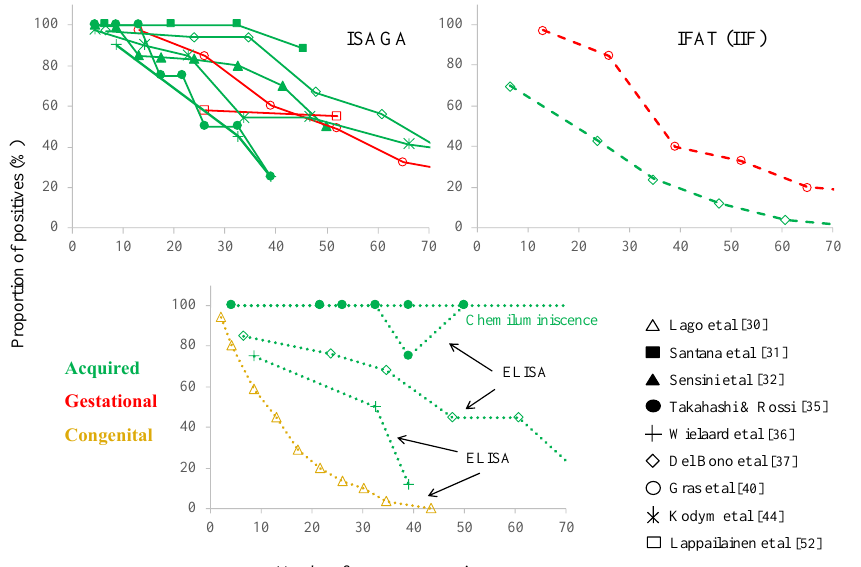
Figure 2. Proportion of cases positive for T. gondii reacting IgM antibodies over time in different groups after initial clinical or serological signs of infection [30 – 32,35 – 37,40,44,52]. Each graph corre- sponds to the test employed, as labelled. ISAGA: Immunosorbent Agglutination Assay; IFAT: Indirect Immunofluorescence Antibody Test (some articles refer to this technique as IIF or IFI); ELISA (EIA): Enzyme-linked Immunosorbent Assay; Chemiluminescence: microbead-based automated test. The abscissa axis cuts off at 70 weeks, but several studies followed the patients for longer periods.